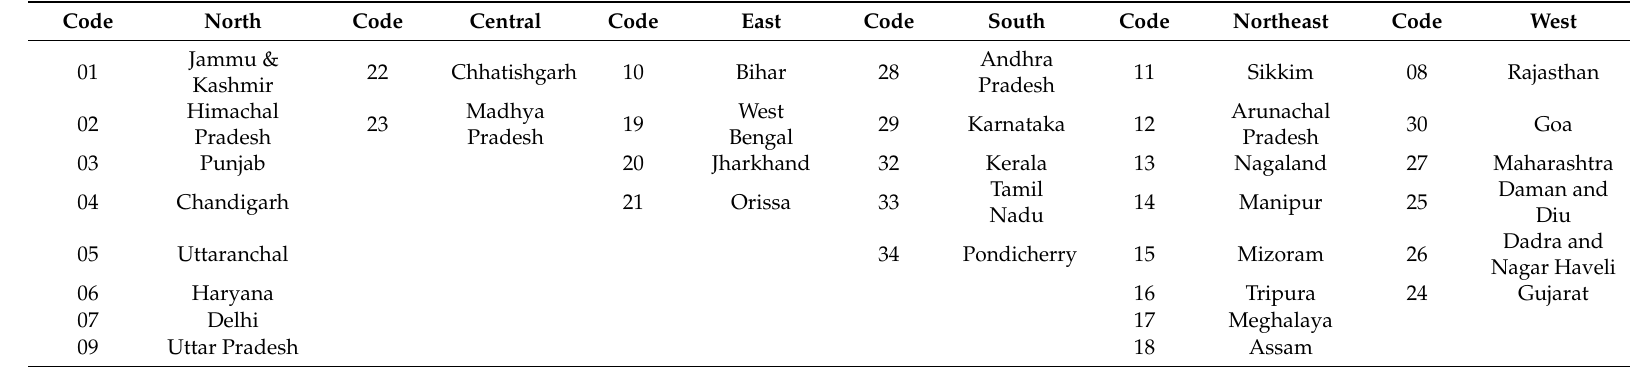
Table A2. Regional definitions: IHDS 2004 / 2005–2011 /